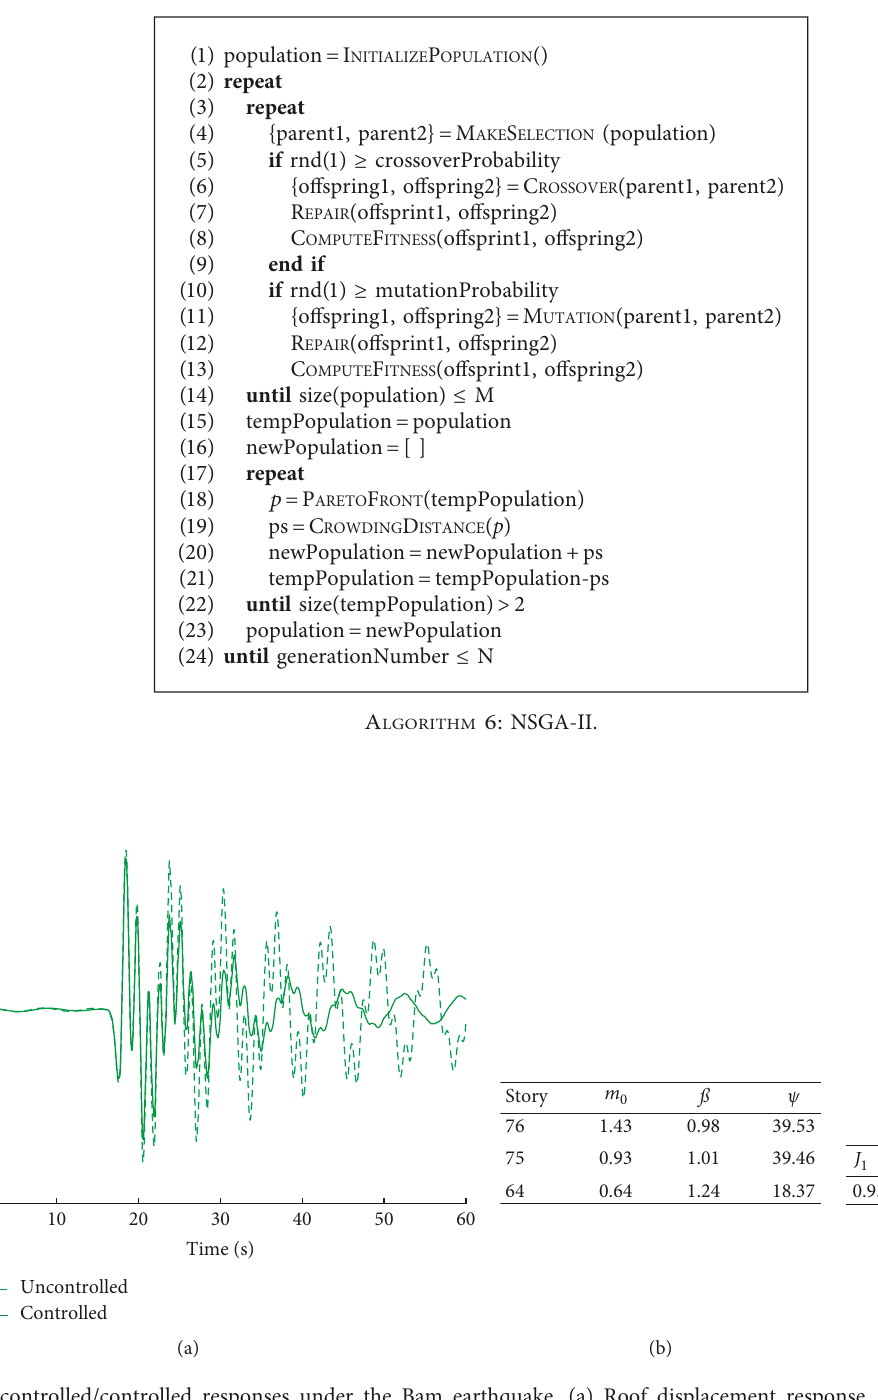
Figure 11: Uncontrolled/controlled responses under the Bam earthquake. (a) Roof displacement response. (b) TMD specifications. (c) Objective